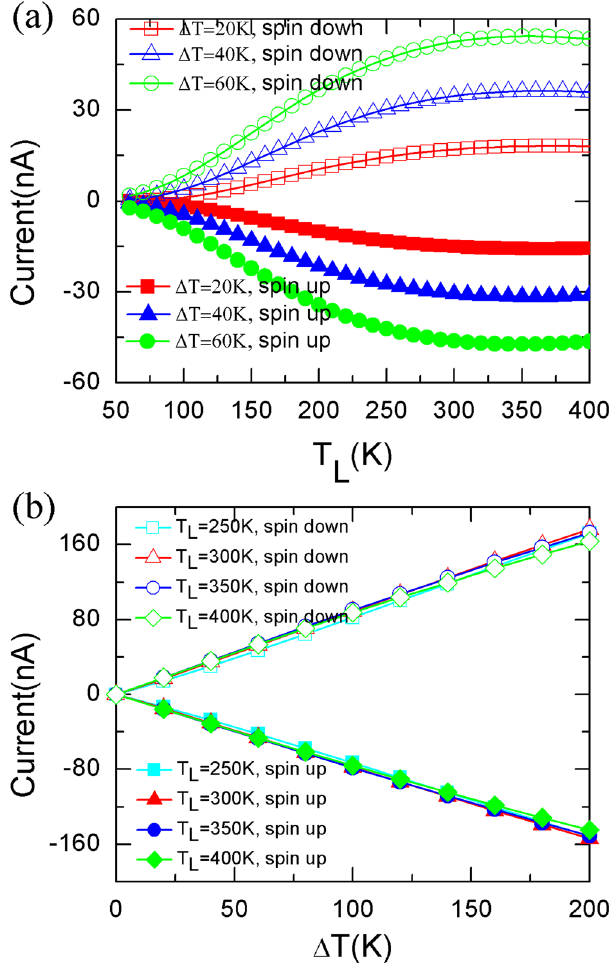
Figure 2. The spin-resolved thermal current. The spin-dependent thermal currents versus T L for different ∆ T ( Δ T = T R − T L ) ( a ) and versus ∆ T for different T L ( b ) for P spin